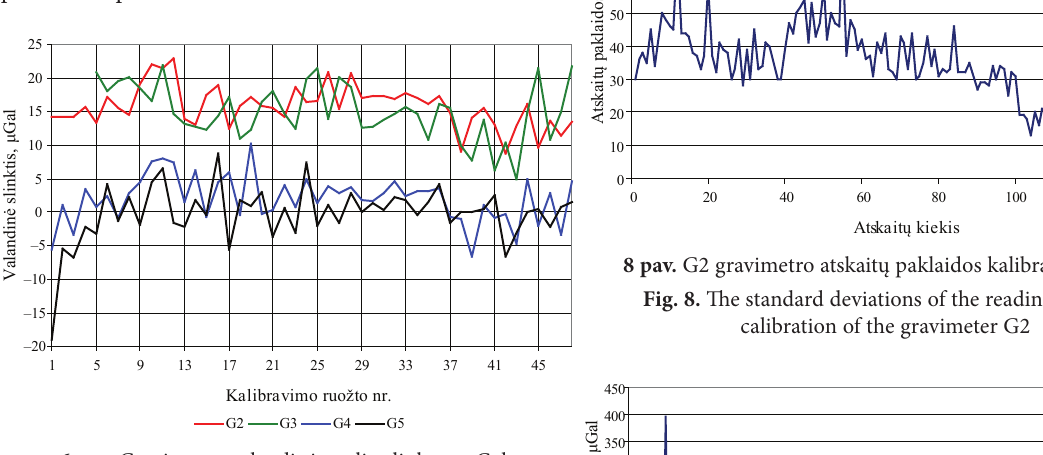
Fig. 6. The zero drift in between the field observations during calibration, μgal g2 ir g3 gravimetrų nulio slinktys siekia 23 μgal/h,